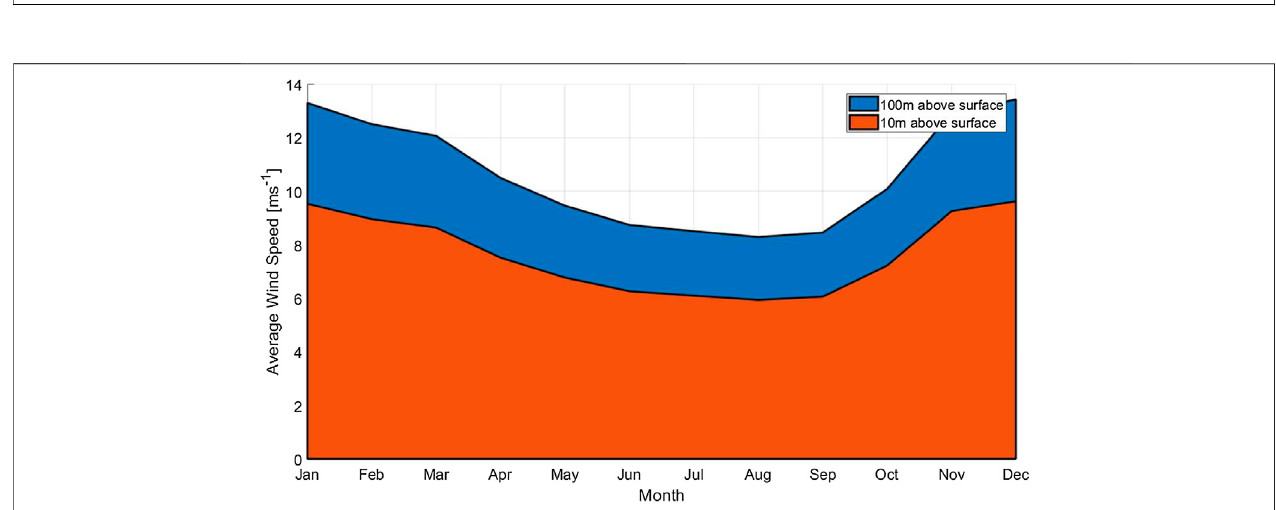
FIGURE 4 | Mean solar radiation throughout the day for each month of the year on Ushant